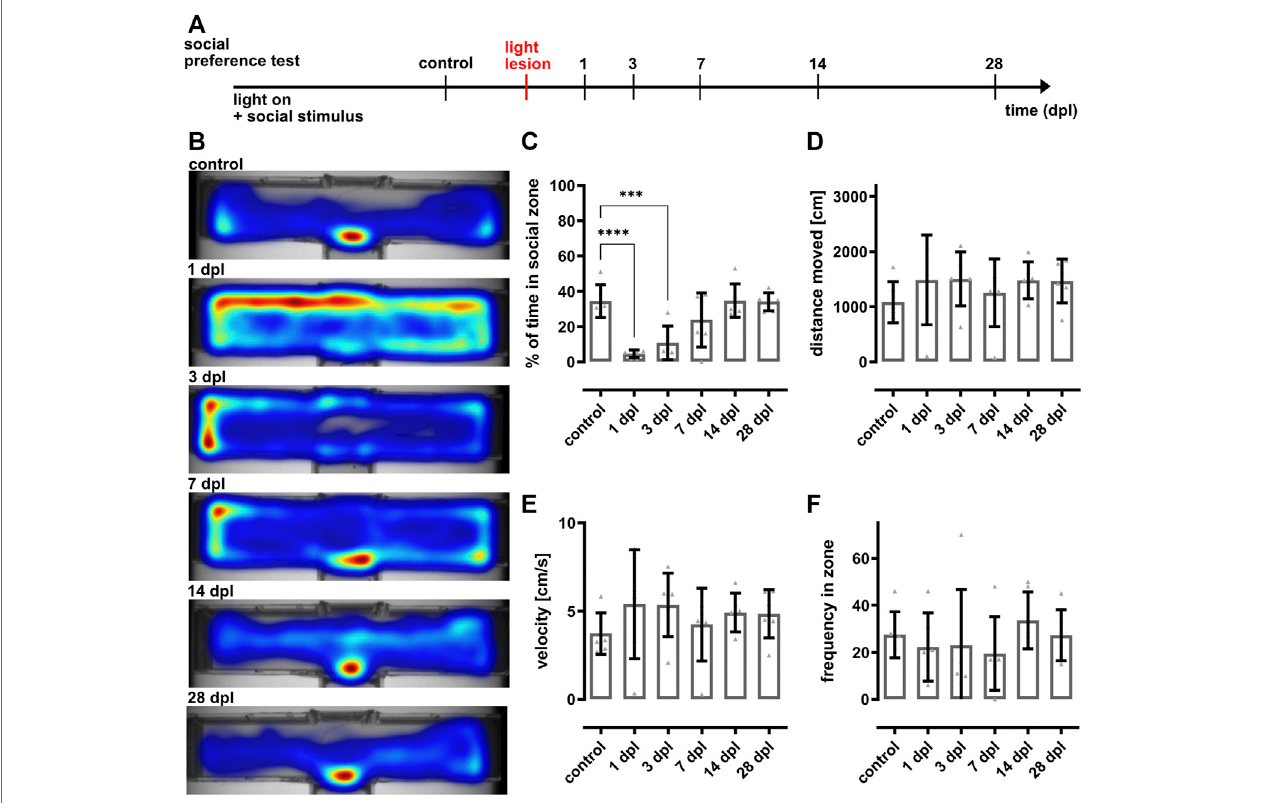
FIGURE 3 | The social preference test reveals recovery of vision within 7 days after light lesion. (A) Experimental timeline. Recordings were performed in light on conditionsin presence ofasocial stimulus beforelightlesion (control) and at1, 3,7,14, and28 days postlesion (dpl). (B) Heat maps ofone representative individual fi sh show that the time spent in the social zone decreasessigni fi cantly following light lesion and returned to baseline from 7 dpl onwards. (C) Quanti fi cation of the time spent in the social zone con fi rms a signi fi cant decrease at 1 and 3 dpl (4.6 ± 2% and 10.8 ± 8.8%) and the return to control levels (34.5 ± 8.4%) after 7 dpl (7 dpl: 23.8 ± 14%, 14 dpl: 34.8 ± 8.7%, 28 dpl: 34.1 ± 4.7%). Quanti fi cations of the distance moved (D) , velocity (E) and frequency in zone (F) did not reveal any signi fi cant changes within the observed timeframe. Statistics: all data are represented as mean ± SD, one-way ANOVA with Dunnett ’ s multiple comparison test against control, p < 0.05